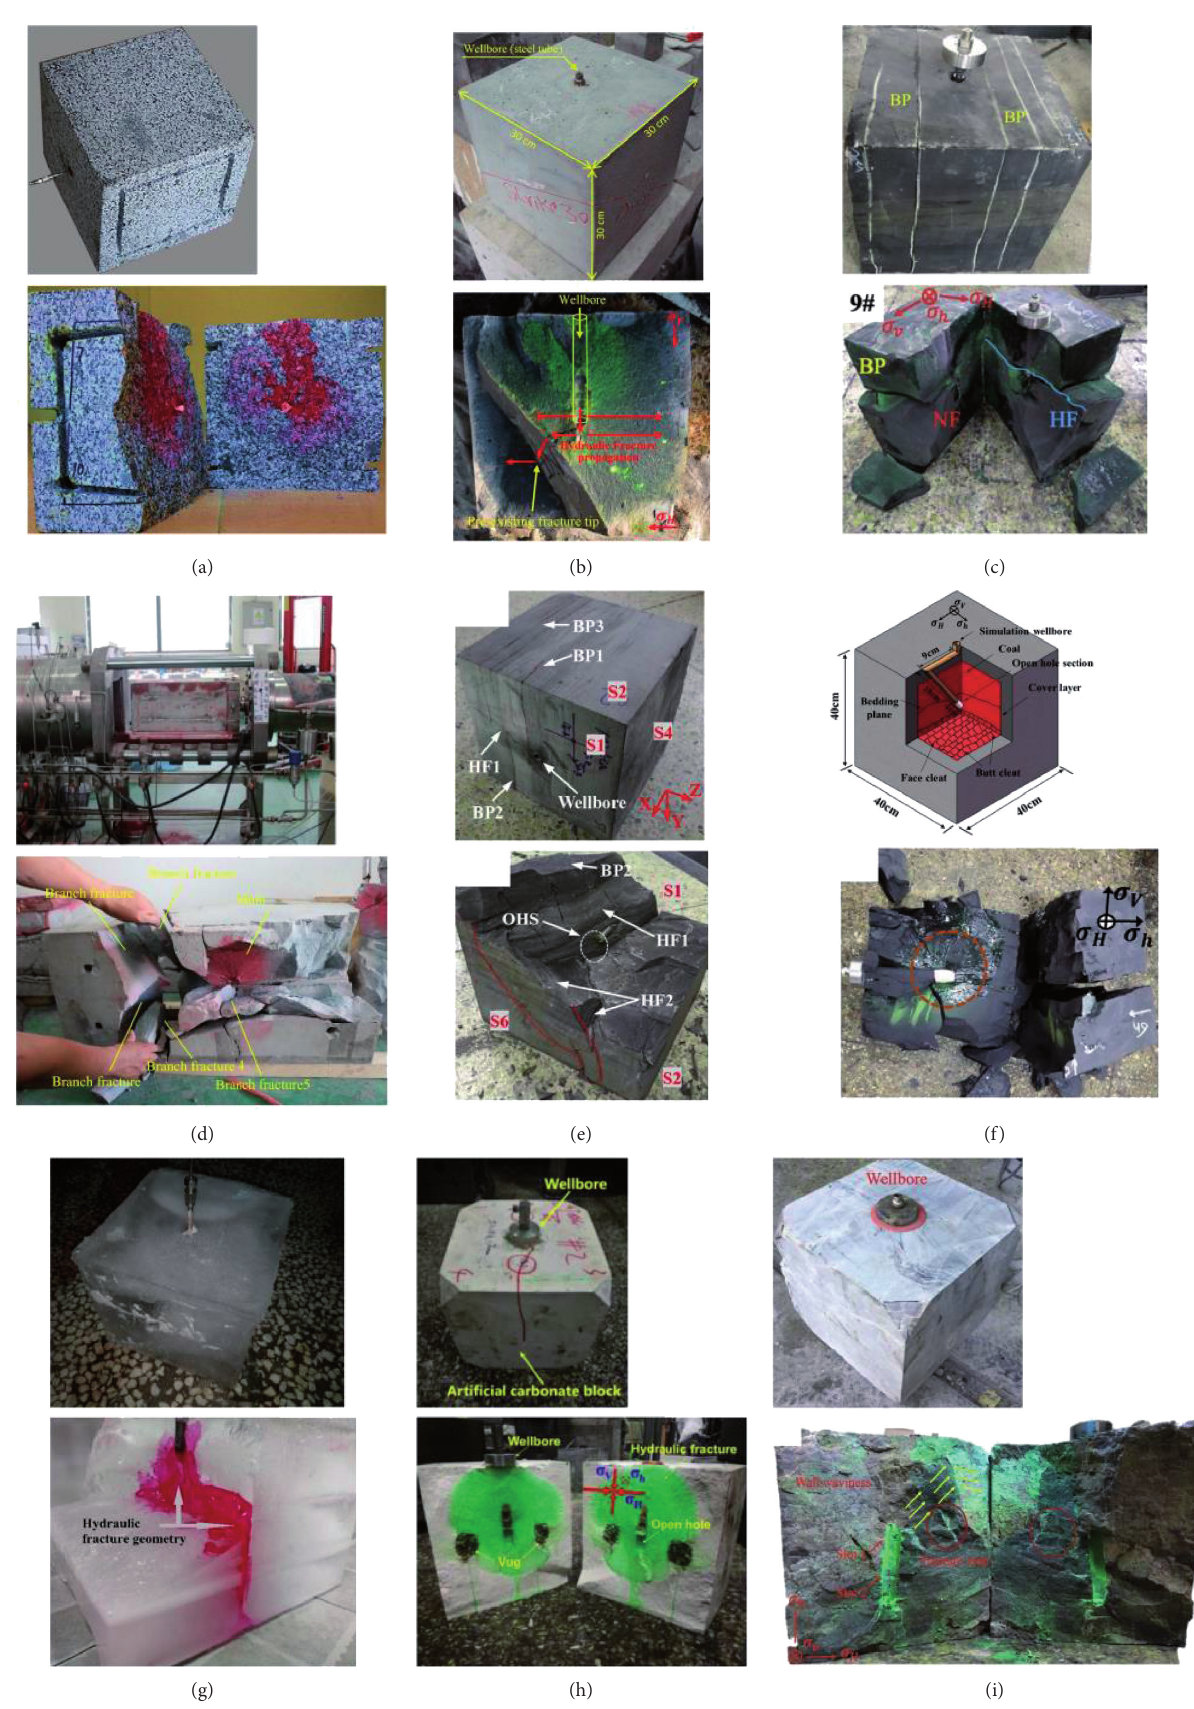
Figure 5: Photos of typical samples made of different materials before and after hydraulic fracturing experiments. (a) Granite [81]. (b) Mortar [85]. (c) Shale [62]. (d) Concrete [84]. (e) Sandstone [79]. (f) Coal [66]. (g) Ice [107]. (h) Carbonate [109]. (i) Limestone